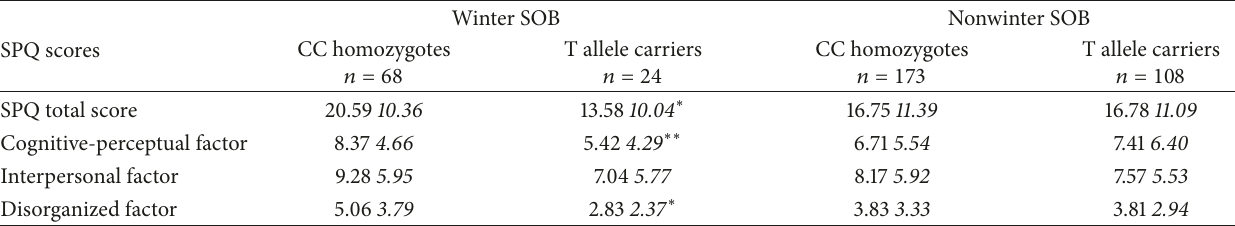
Table 4: Means and SD of the SPQ total and factor scores by SOB and IL4 genotype in the extended sample.